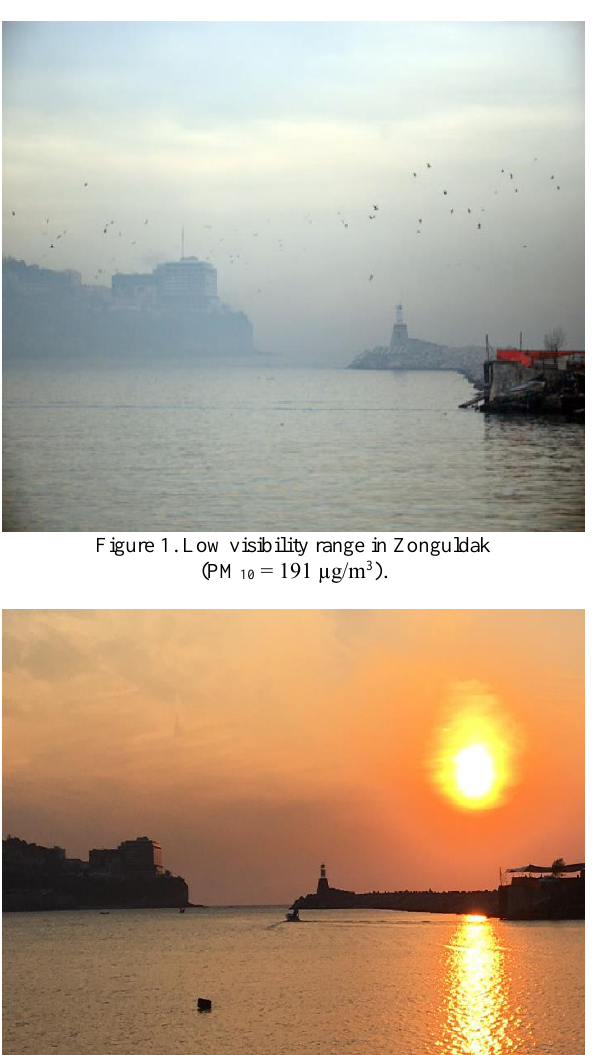
Figure 4. PM 10 time series of